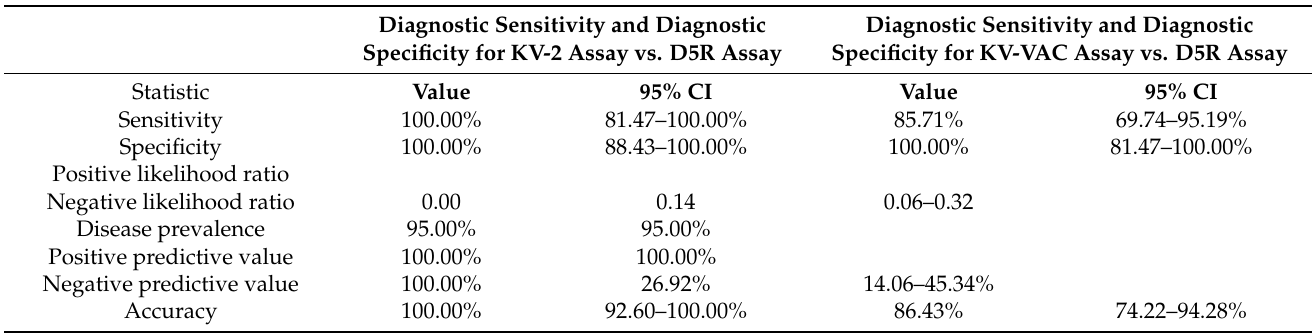
Table 10. Diagnostic sensitivity and diagnostic specificity for the KV-2 and KV-VAC assays vs. D5R assay.